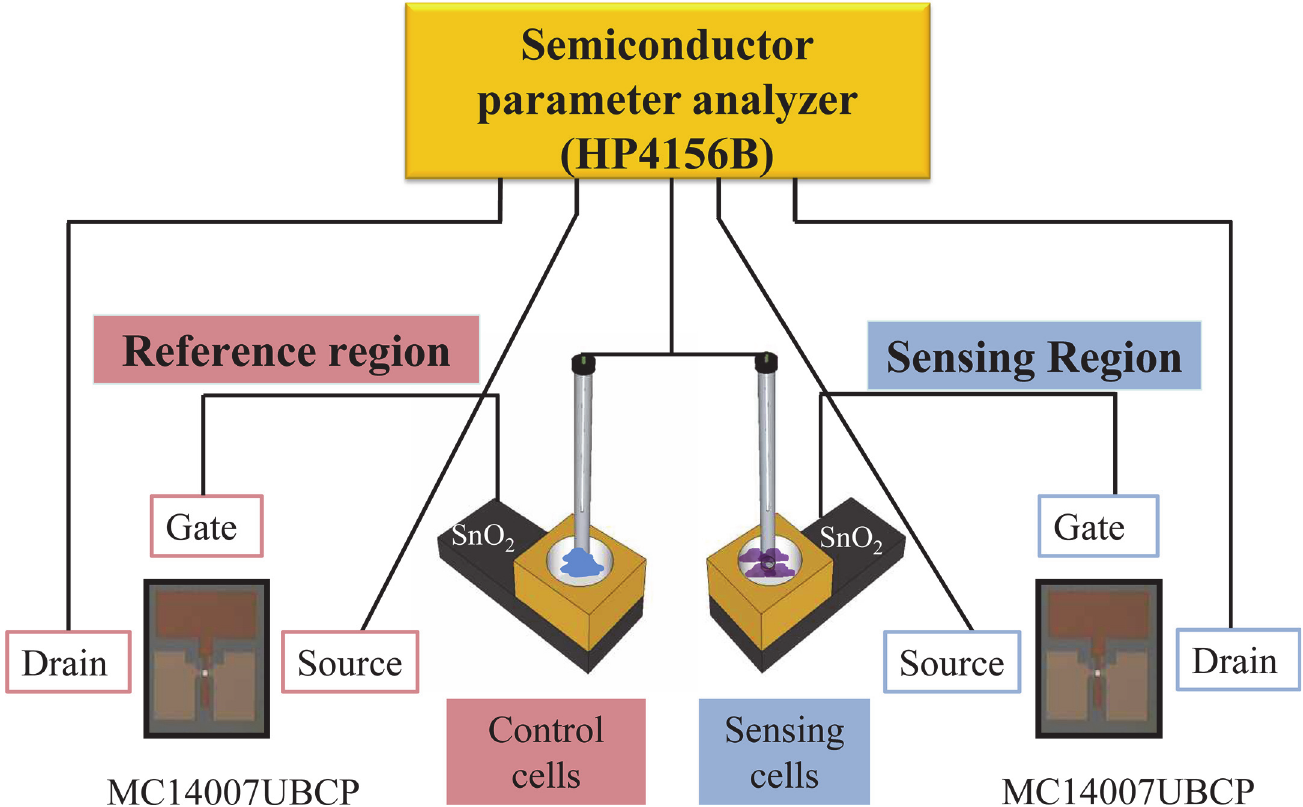
Fig 1. Top view image of the EG-ISFET sensor device. The EG-ISFET sensor consists of an independent reference and sensing region for simultaneous measurements of samples from patient and control groups. A commercially available transistor (MC14007UBCP) was used as the MOSFET part of the sensor. The gate terminal of both sensing and reference regions was segregated from the conventional ISFET device. A SnO 2 membrane was deposited on the gate terminal of the EG-ISFET sensor and used as the sensing membrane. Response currents generated were measured using a Hewlett-Packard 4156B High-Precision Semiconductor Parameter